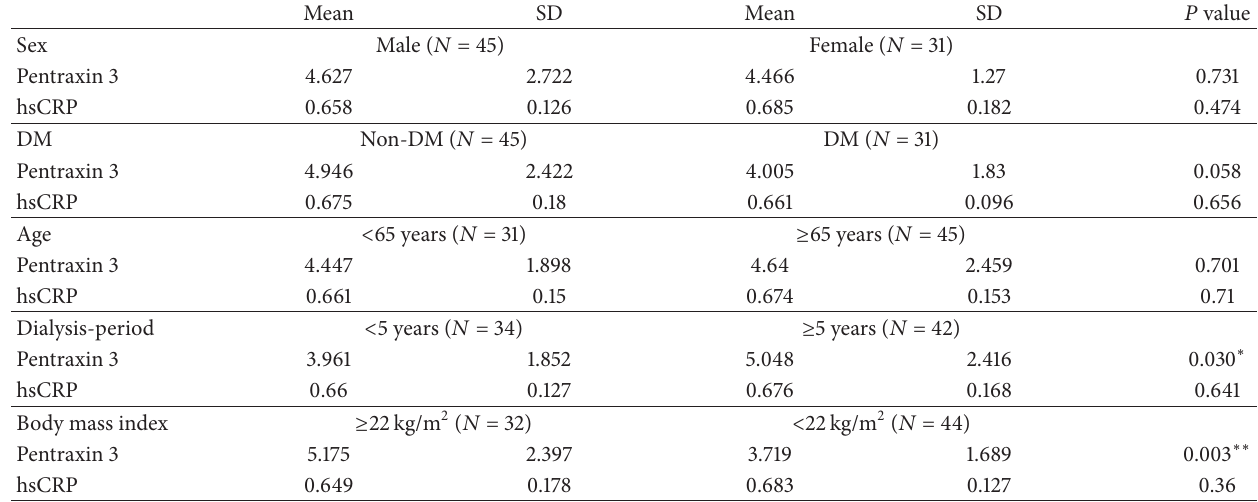
Table 2: Comparison of pentraxin levels in baseline year among the